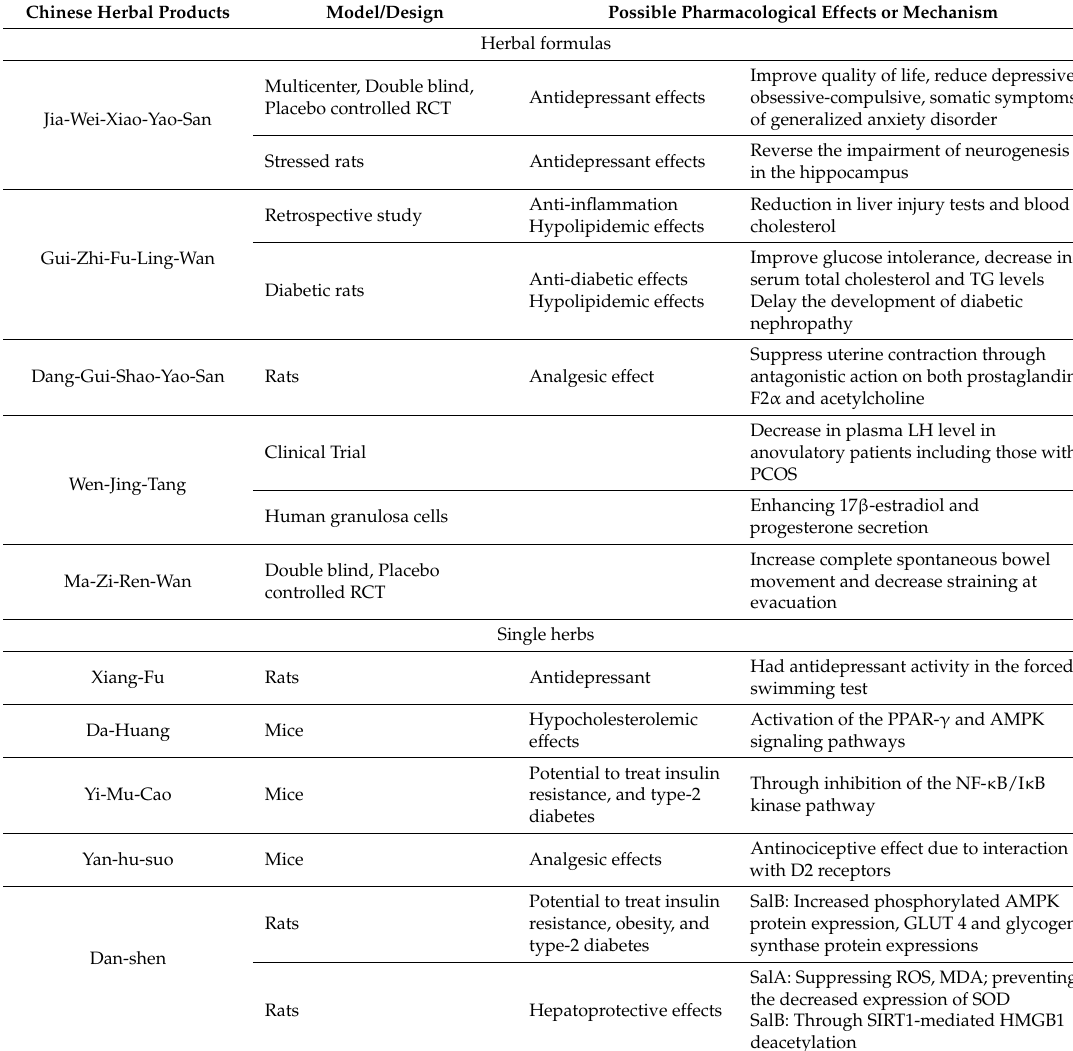
Table 5. Possible pharmacological effects or mechanisms of the most common herbal formulas and single herbs for the treatment of patients with